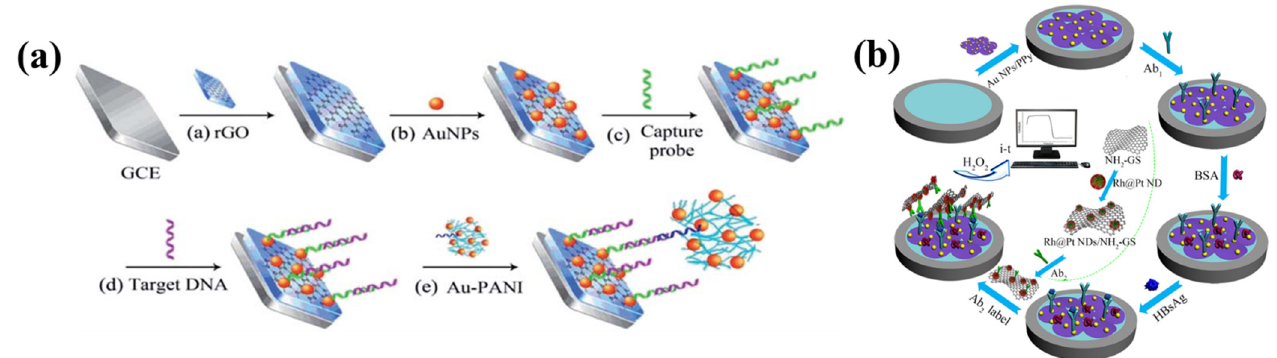
Figure 6. ( a ) A schematic depiction of the stepwise electrode modification process and detection of target DN. ( b ) A flowchart illustrating the stepwise processes involved in the fabricating of a sandwich-type electrochemical immunosensor for the detection of hepatitis B surface antigen. Reproduced with permission from [70,71].